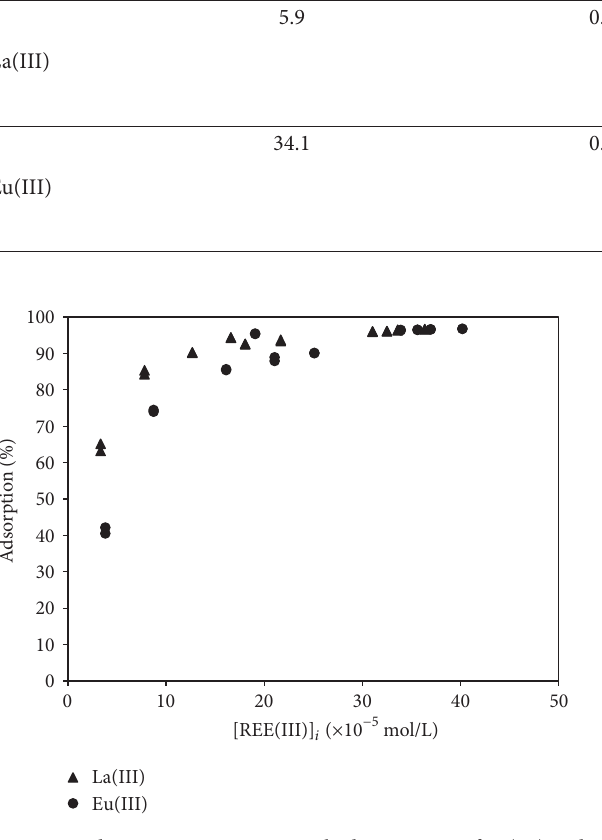
F 6: Adsorption percentages on hydroxyapatite of La(III) and Eu(III) versus initial concentrations.